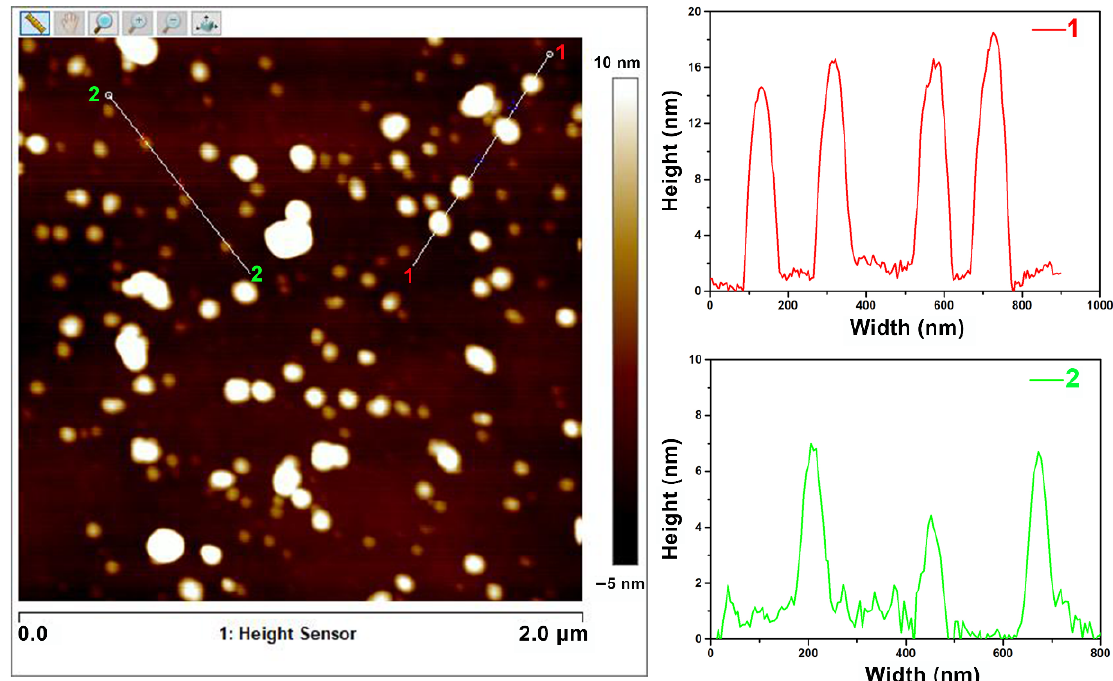
Figure 1. SPM micromorphology of NCDs and corresponding height profiles of lines.